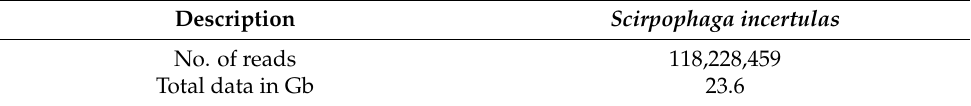
Table 5. RNA-seq